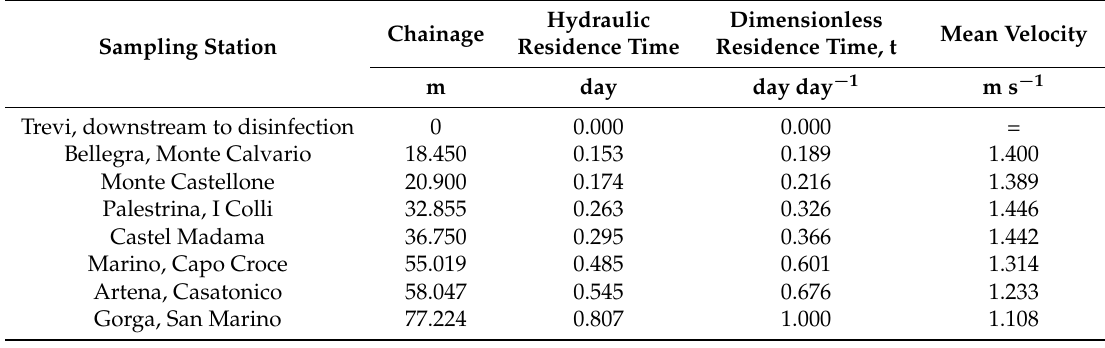
Table 2. Simulation results: hydraulic residence times in the network calculated in the sampling stations.